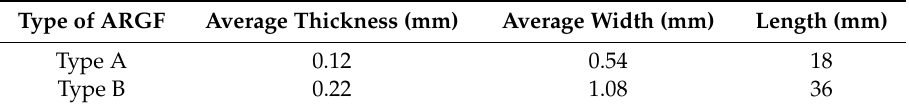
Figure 3. Alkali-resistant glass fibers (ARGF) used in the test: ( a ) Type A ARGF; and, ( b ) Type B ARGF. Table 2. Sizes of ARGF slices.